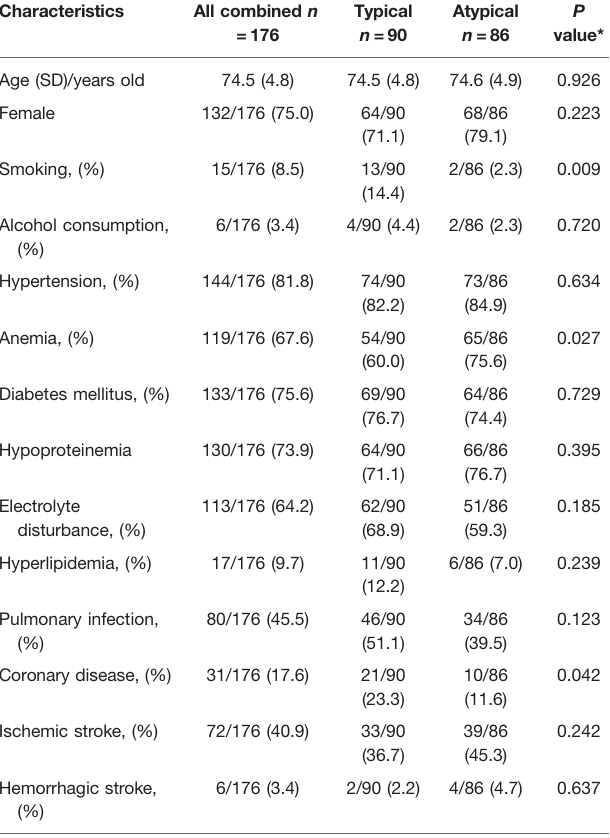
TABLE 1 | Baseline information of elder patients with ruptured intracranial aneurysms.